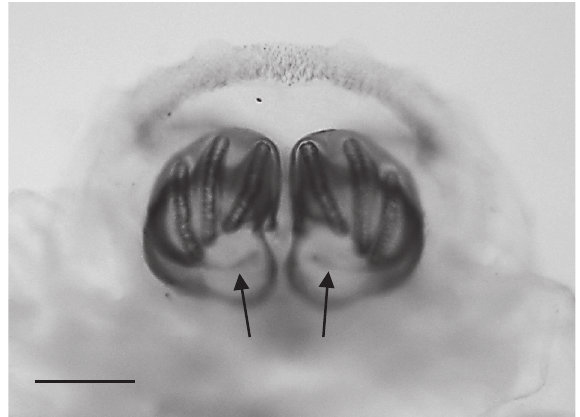
Figure 2: Sarcophaga spp. third instar larva: LM image, overview of kidney-shaped posterior spiracles with ventral arches (arrows) not reaching the inner arch area . Scale bar: 100 𝜇 m.